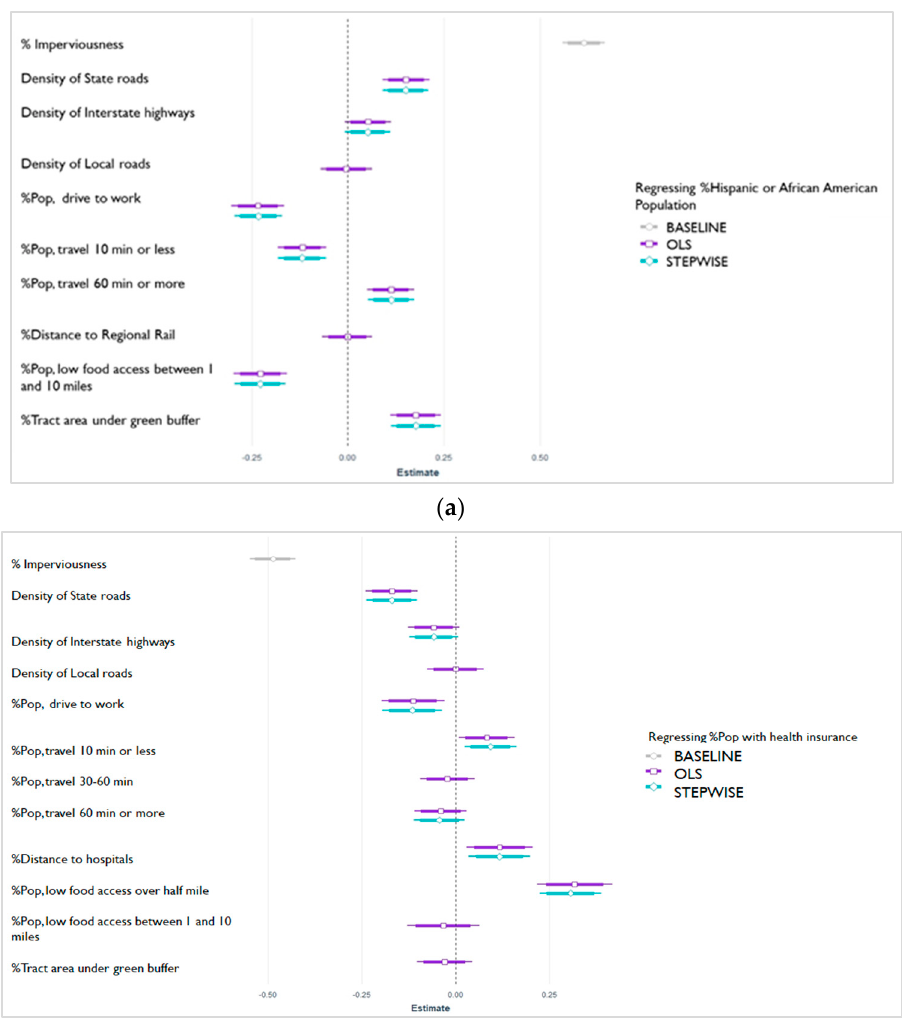
Figure 2. Variable importance in base U ‐ R model and infrastructure models for ( a ) racial equity and ( b ) Wellbeing.